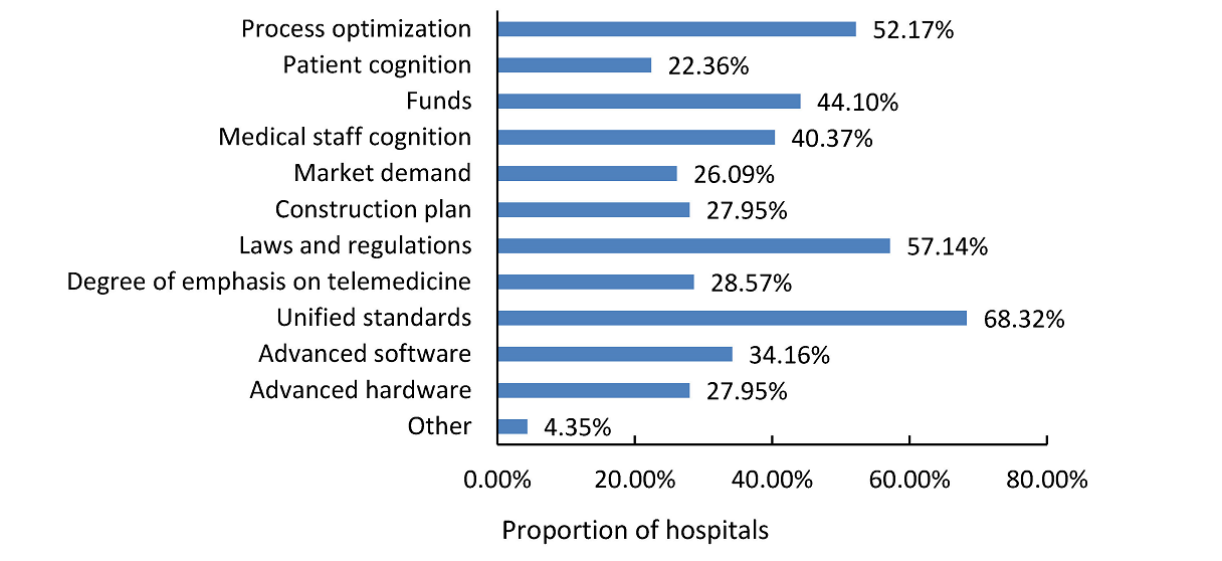
Figure 9. Key factors affecting the development of telemedicine in tertiary hospitals of